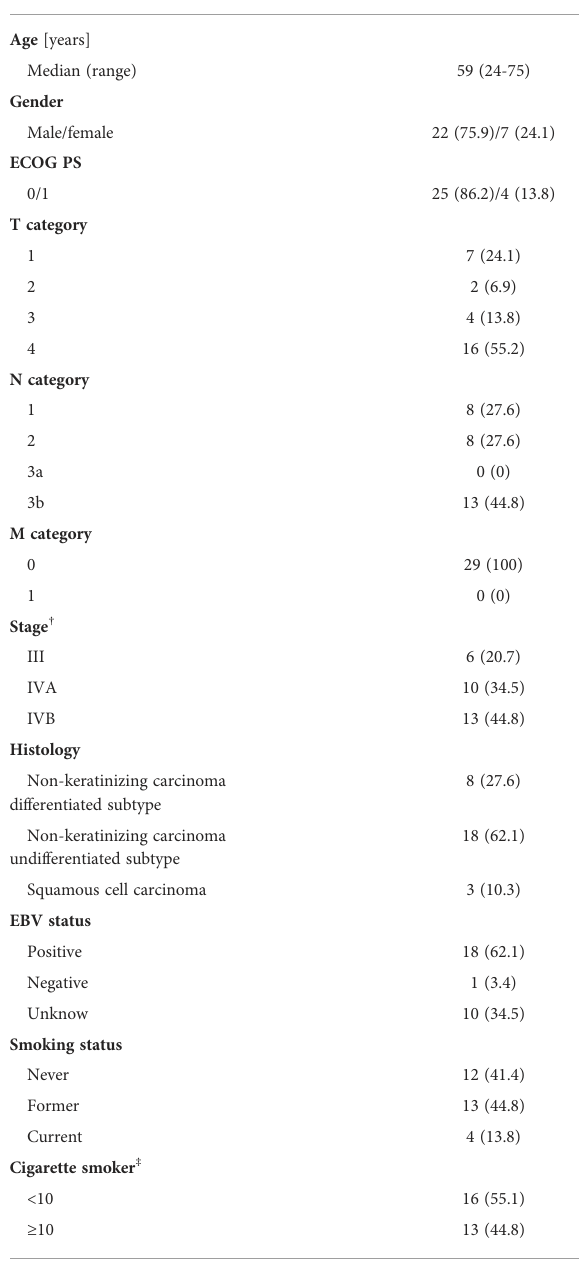
TABLE 1 Patient characteristics